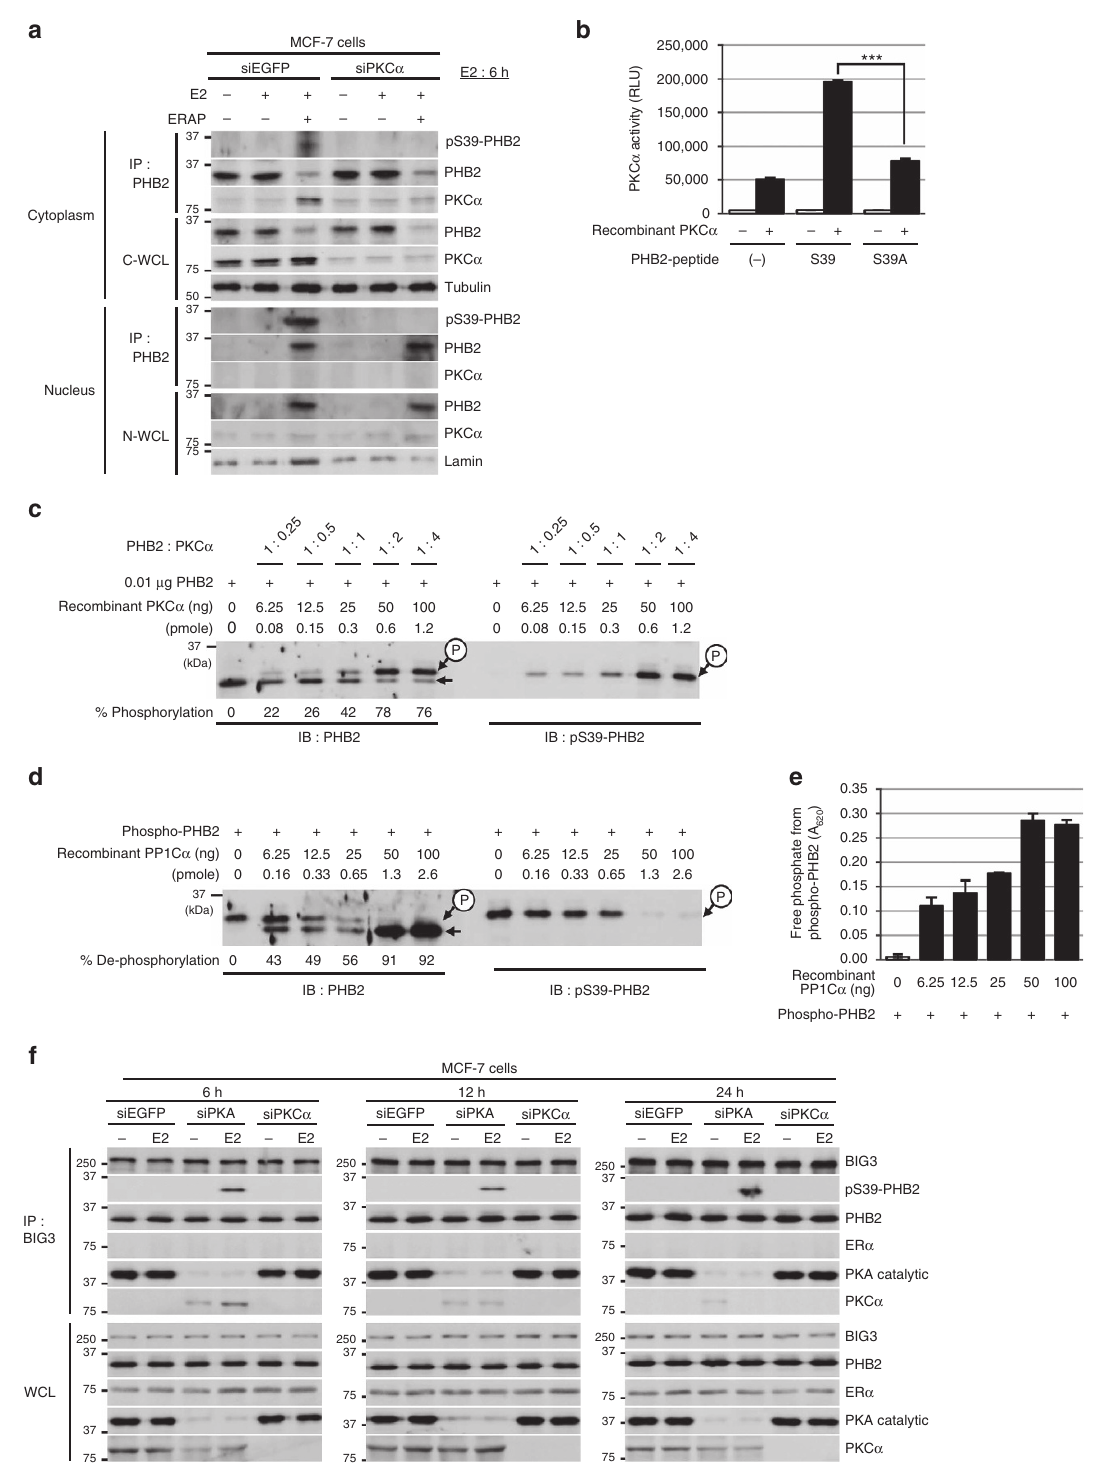
Figure 3 | PHB2 is activated by phosphorylation at Ser39 via PKC a . ( a ) The inhibitory effects of siPKC a on PHB2 phosphorylation at S39 in PHB2 immunoprecipitates of cytoplasmic and nuclear fractions in MCF-7 cells. C-WCL, total cytoplasmic lysates; N-WCL, total nuclear lysates. ( b ) In vitro PKC a activation assay of PHB2 using engineered peptides representing S39 and the alanine mutant of S39 (S39A). These data represent the means ± s.e.m. of three independent experiments. ( c ) Phosphorylation at S39 in the recombinant full-length PHB2 by PKC a using Phos-tag SDS–PAGE and western blot analysis with anti-PHB2 and anti-pS39-PHB2 antibodies. ( d ) Dephosphorylation of full-length PHB2 phosphorylation at S39 by PP1C a using Phos-tag SDS–PAGE and western blot analysis with anti-PHB2 and anti-pS39-PHB2 antibodies. ( e ) Phosphatase activity of PP1C a against purified, recombinant full-length PHB2 phosphorylation at S39. These data represent the means ± s.e.m. of three independent experiments. ( f ) The effects of siPKA and siPKC a on BIG3–PHB2 complexes and PHB2 S39-phosphorylation in MCF-7 cells after E2 stimulation for 6h (left), 12h (middle) and 24h (right). *** P o 0.001 (two-sided Student’s t